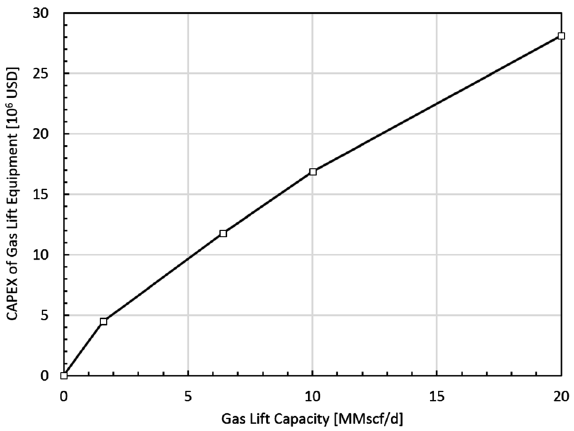
Fig. 16 Cash flow analysis for the reference case of Table 2